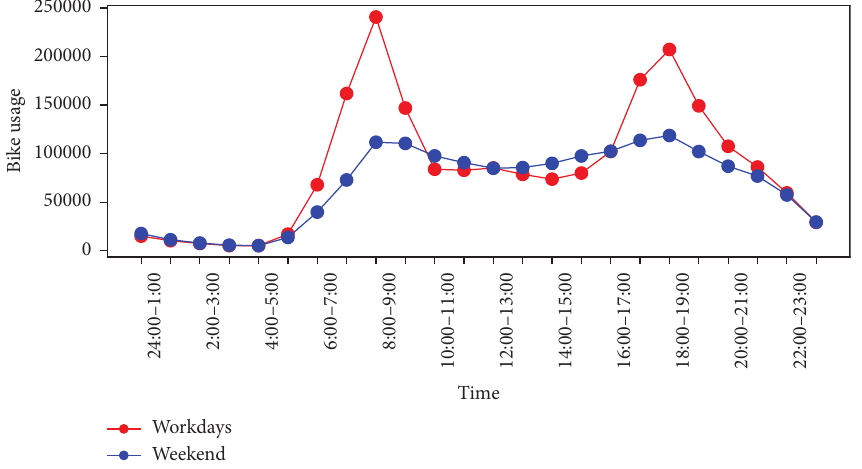
Figure 1: Bike-sharing usage on workdays and weekends.